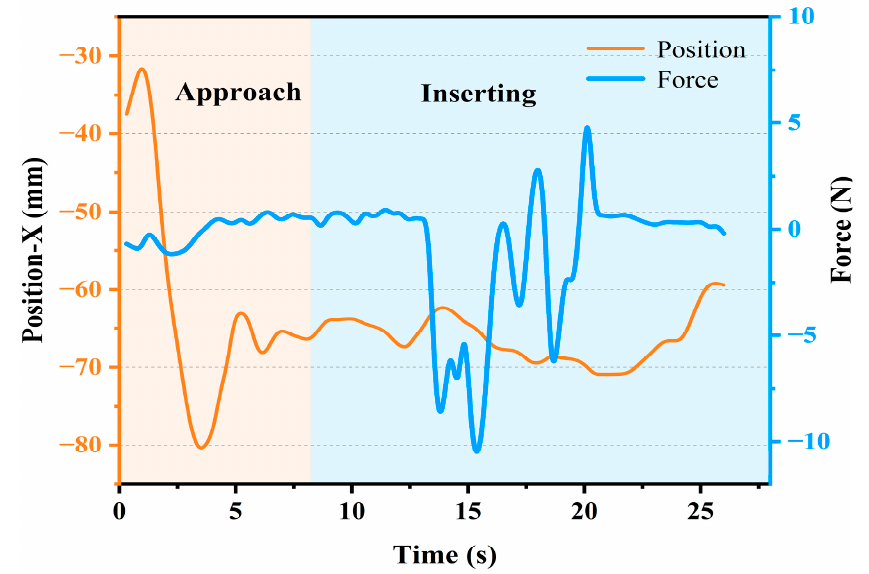
Figure 8. The contact force and the trajectory using the master–remote position controller.